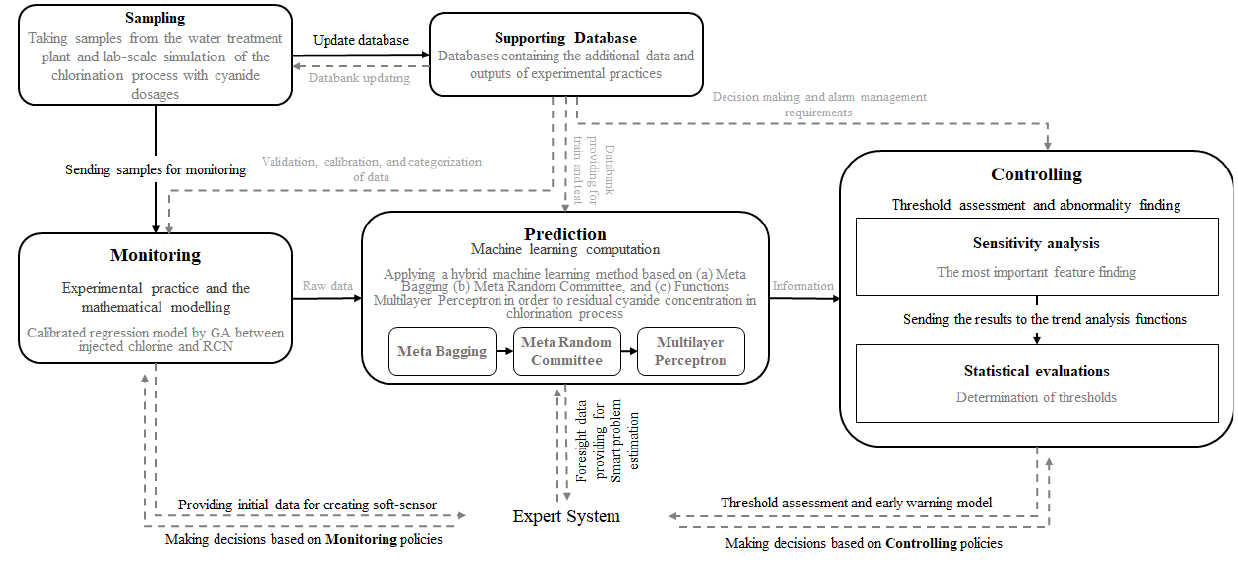
Figure 3. The details of DSS in the present research.